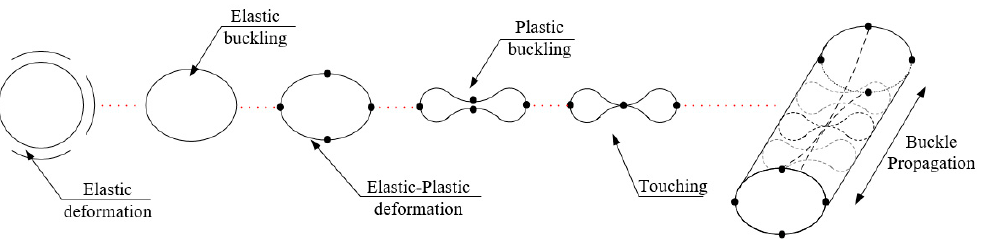
Figure 13. Buckling progress for pipeline.